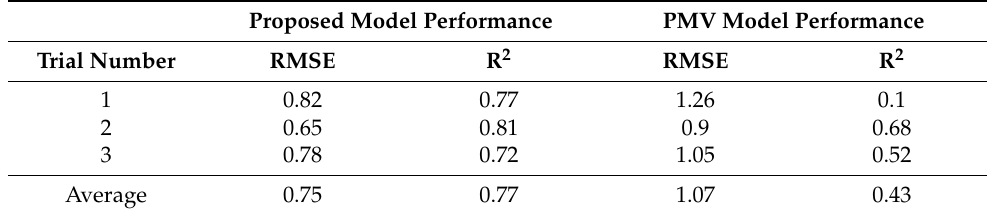
Table 4. Comparisons between the proposed model and PMV